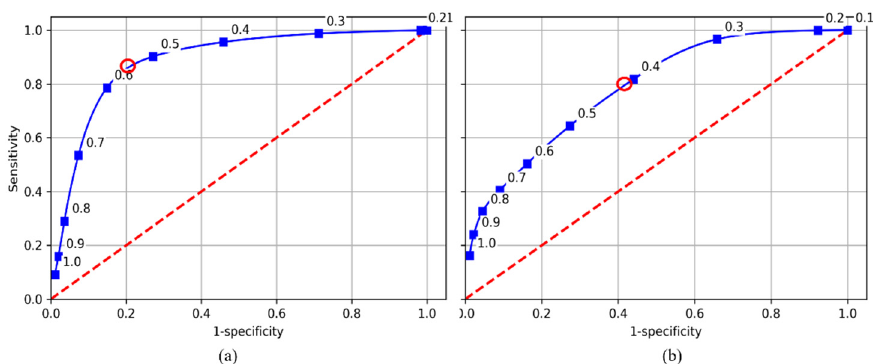
Figure 3. Receiver operating curves (ROCs) for ( a ) Sentinel-1 and ( b ) PALSAR-2 based classifications. The marked points indicate the Sensitivity and 1-Specificity obtained when using a given CV thr value. The dashed line is the line of no discrimination. Red circles indicate the CV thr value yielding the best J-statistic values.